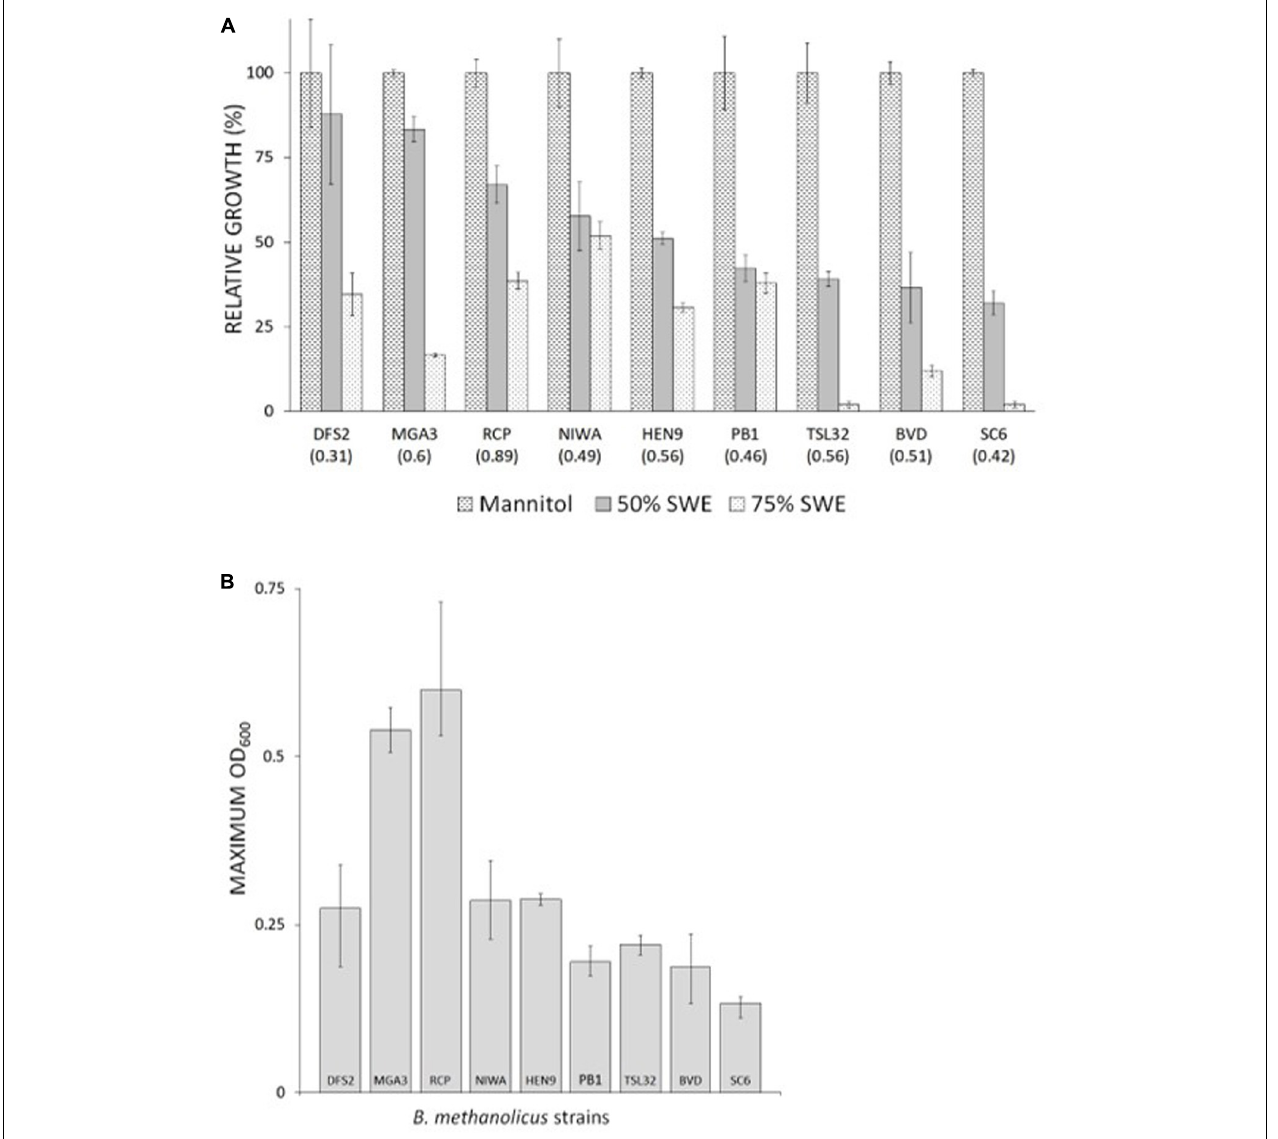
FIGURE 2 | Tolerance of B. methanolicus wild type strains to grow in the presence of SWE. Cultivations were made in microwell plates for 20–24 h and with added mannitol to final concentration of 10 g/l. (A) Growth in the presence of 50 and 75% (v/v) SWE. 100% relative growth represent the maximum OD 600 value obtained for each strain in Man 10 medium. Obtained OD 600 values in Man 10 medium are given in parentheses for each strain. (B) Maximum OD 600 values of B. methanolicus wild type strains in the presence of 50% (v/v) SWE. Maximum and minimum measured values for quadruplicate cultures are indicated.